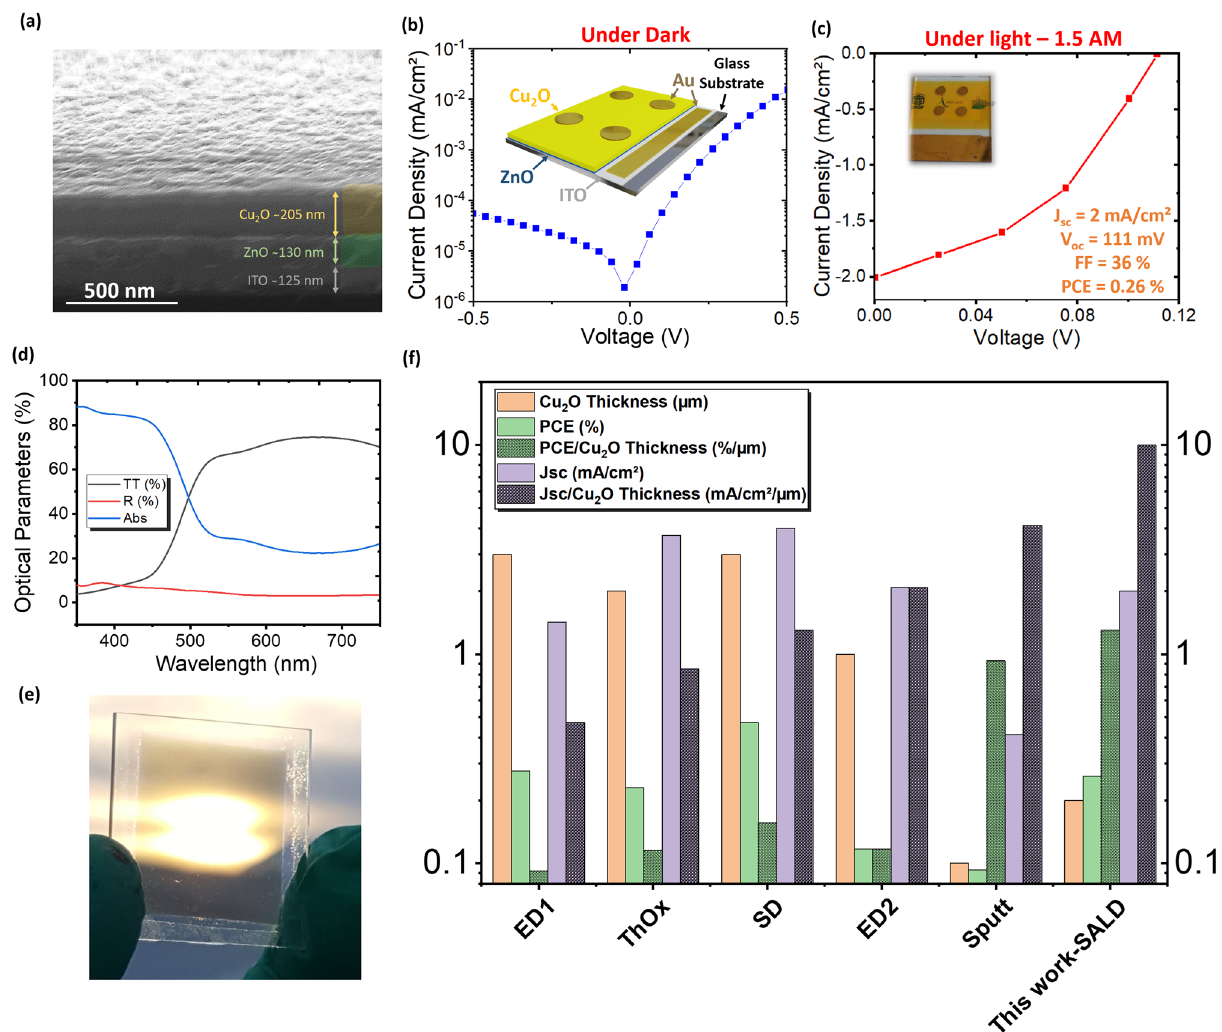
Fig. 5 Evaluation of Cu 2 O/ZnO devices. a SEM cross-section of a Cu 2 O/ZnO solar harvester. b Dark I – V curve of the fabricated Cu 2 O/ZnO PN heterojunction solar harvester (the inset shows a schematic view of the device). c Light I – V curve and resulting device parameters (the inset shows an image of the semitransparent solar harvester). d Total transmittance (TT), re fl ectance (R), and absorbance (Abs), of the Cu 2 O/ZnO solar harvester device deposited on top of an ITO/Glass substrate. e Image of the semitransparent device with a contrast of the sun illumination and the Néron mountain in the background. f Comparison between Cu 2 O/ZnO devices fabricated with different techniques (ED1 65 -ThOx 66 -SD 6 -ED2 67 - Sputt 68 ). The